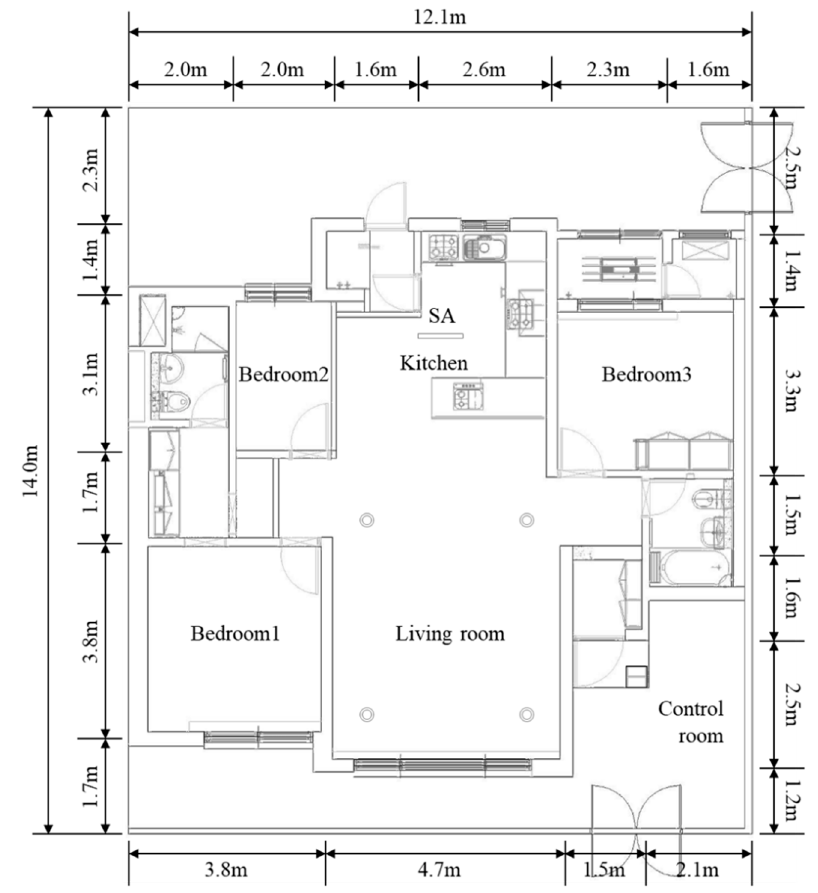
Figure 1. Floor plan of the target apartment.